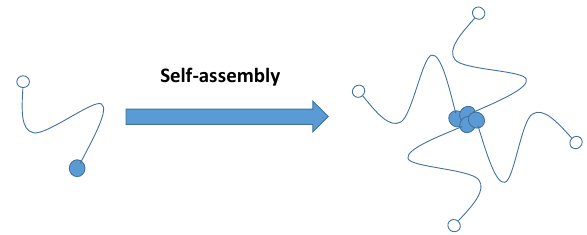
Figure 3. Illustration of drug co-delivery (blue and white dots) using a nanoconjugate through a spacer [57].